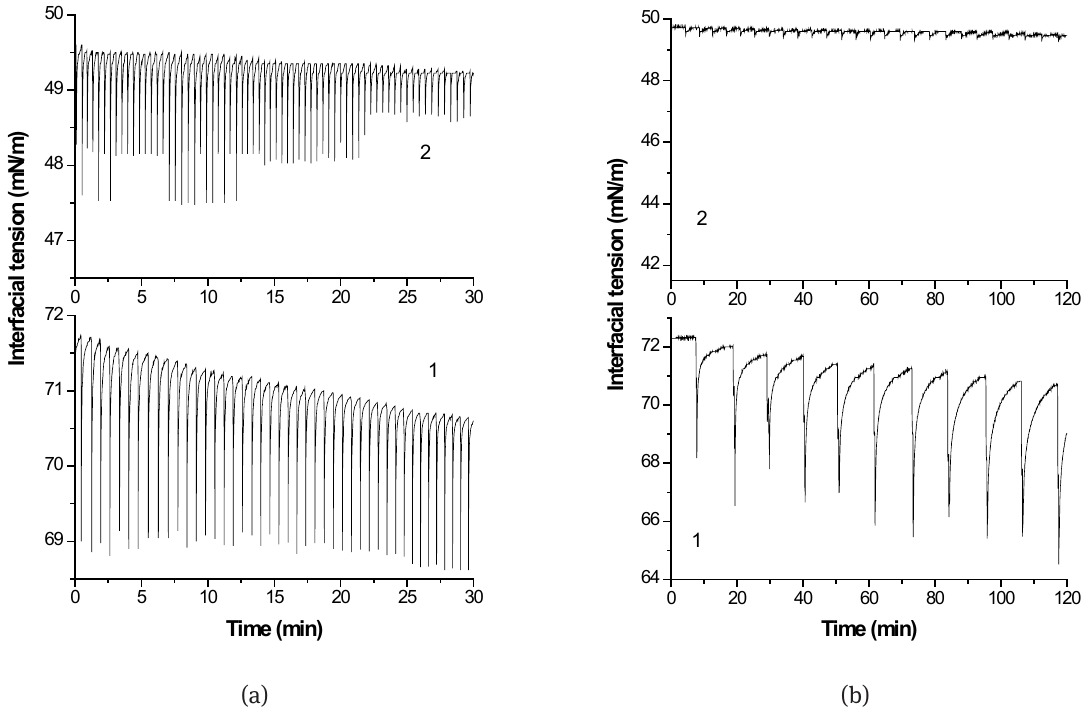
Figure 3: Spontaneous oscillations of the interfacial tension produced by a) pentanol droplet, b) octanol droplet: 1 – air/water interface, 2 – heptane/water interface. Reprinted with permission from [7]. Copyright 2005 American Chemical Society.